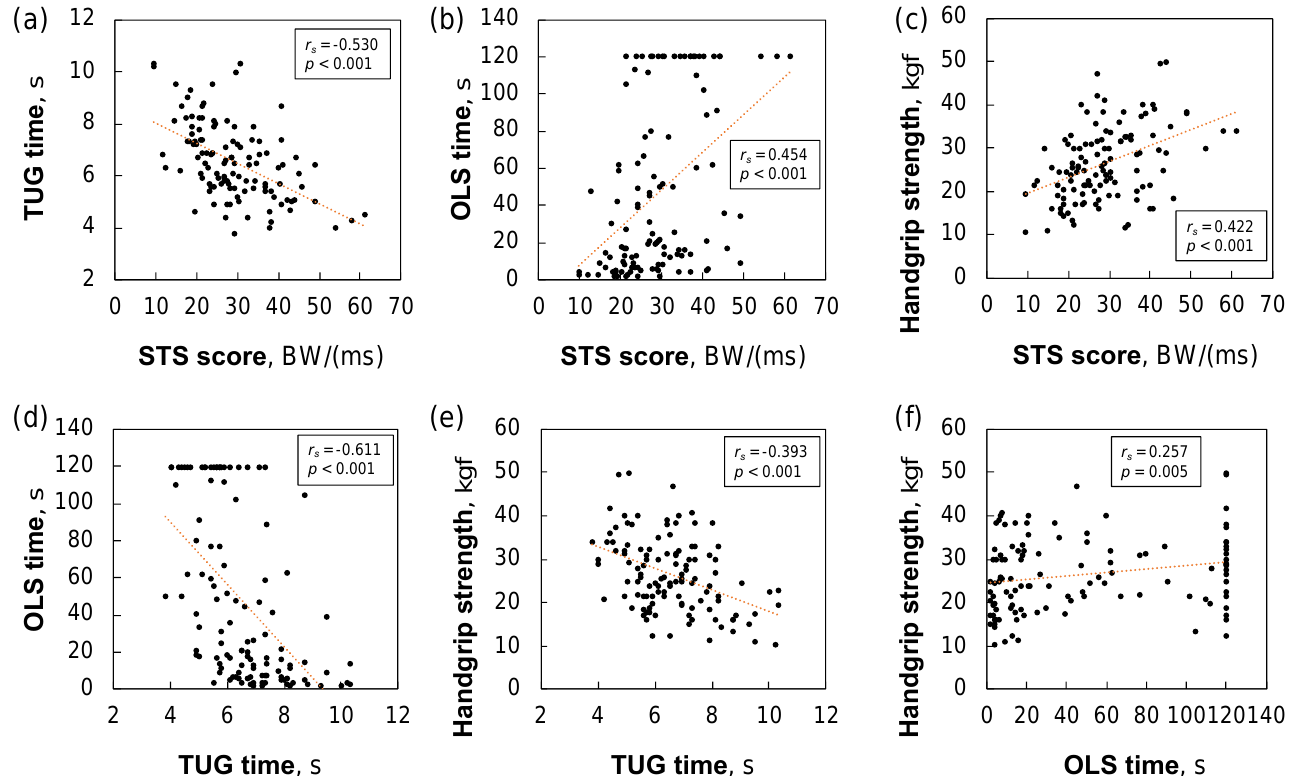
Figure 2. Scatter plots of the variables used for Spearman ’ s rank correlation coefficient between ( a ) STS score and TUG time, ( b ) STS score and OLS time, ( c ) STS score and handgrip strength, ( d ) TUG time and OLS time, ( e ) TUG time and handgrip strength, and ( f ) OLS time and handgrip strength. STS, sit-to-stand; TUG, timed up and go; OLS, one-leg standing.